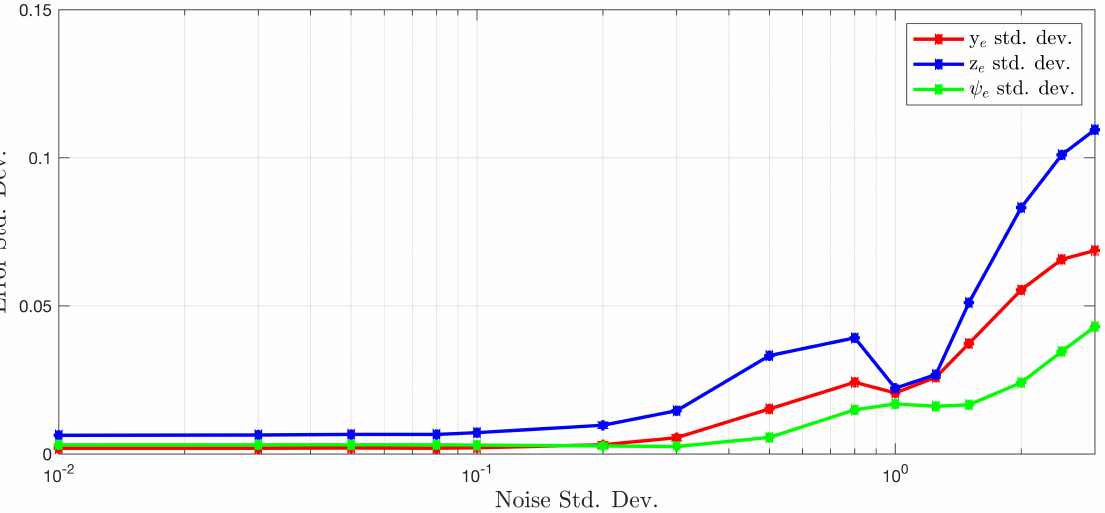
Figure 12. Evolution of measurement error distributions as standard deviation of sensor noise increases.